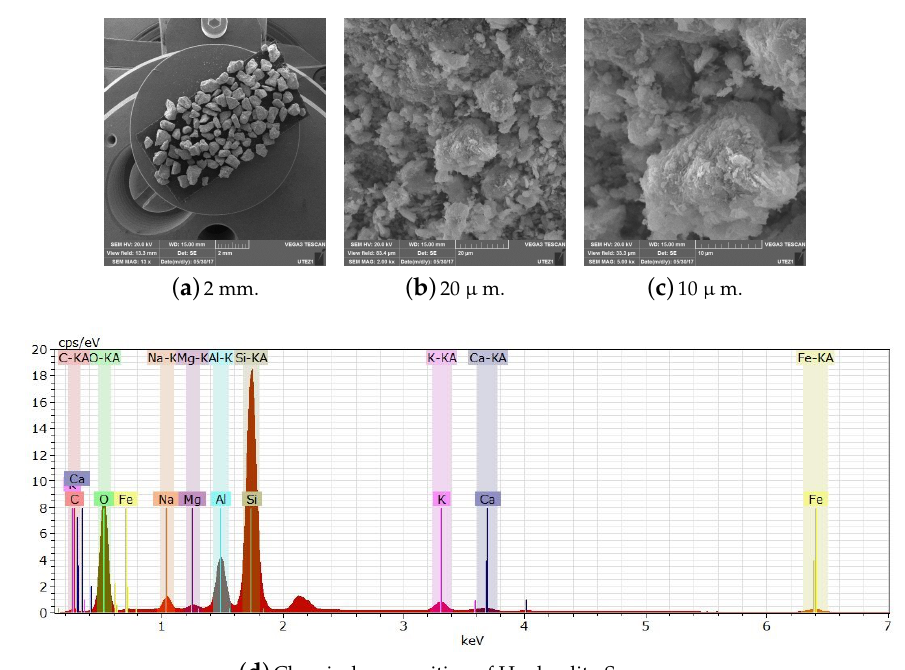
Figure A16. Scale display through SEM and chemical composition of Heulandite-Sonora.